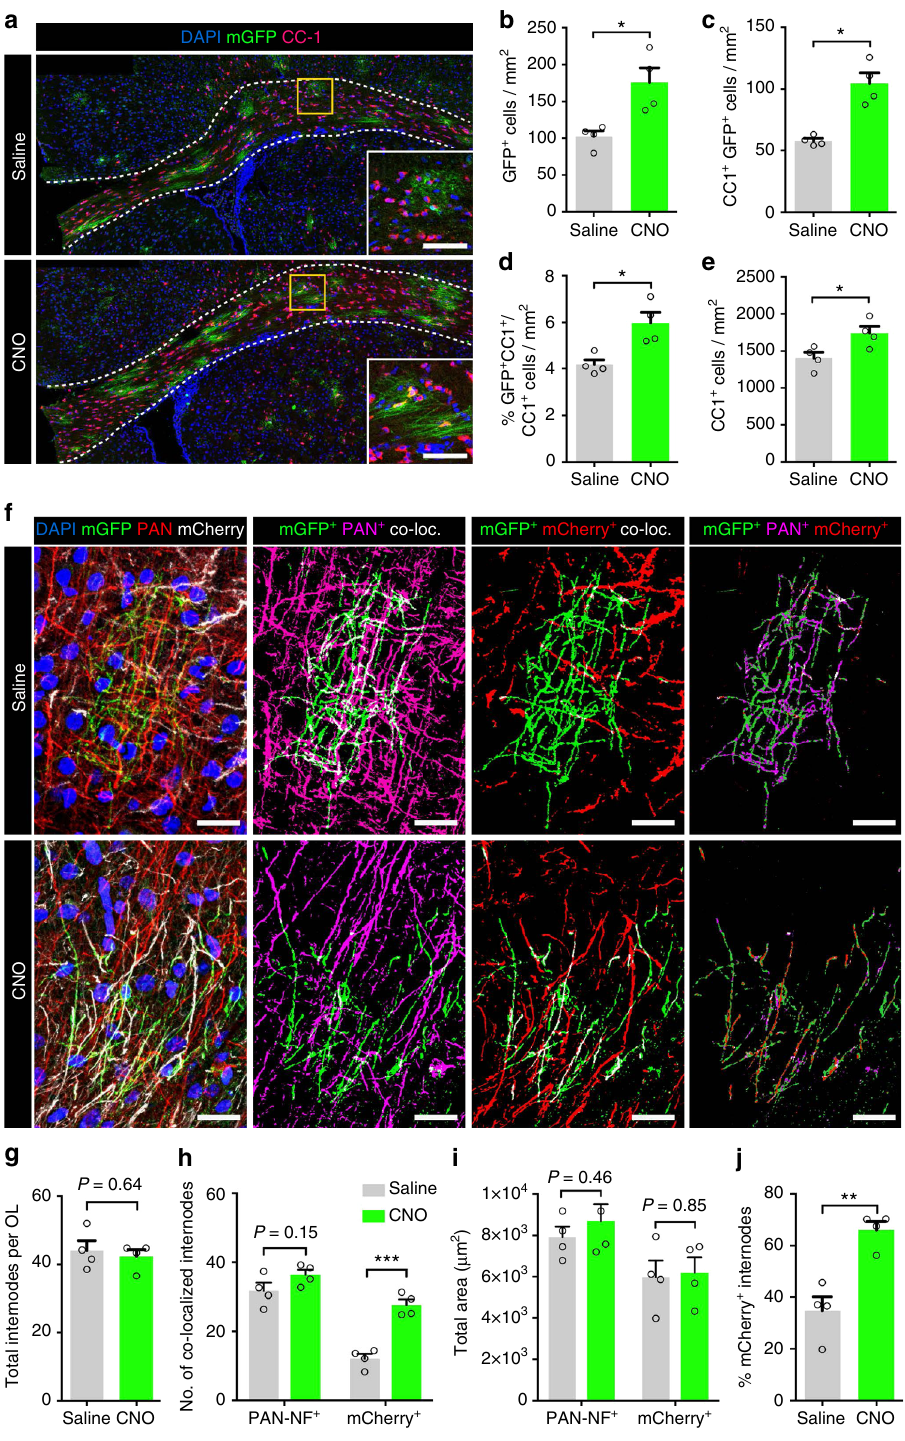
Fig. 8 Newly generated oligodendrocytes preferentially target axons with higher levels of activity. a Representative images of the corpus callosum of PdgfR α -CreERT 2 : Tau-mGFP mice that had undergone 1 week of treatment with either CNO or saline. Coronal sections were immunolabeled with mature oligodendrocyte marker CC1 (magenta) and GFP (green); insets show a higher number of doubly labeled GFP + /CC1 + cells in CNO-treated mice (bottom inset) compared to saline controls (top inset). b , c Quanti fi cation of the density of GFP + cells ( b ) and the density of CC1 + /GFP + cells ( c ) in the corpus callosum of CNO- or saline-treated mice. d , e Quanti fi cation of the percentage of all CC1 + cells that were GFP + ( d ) and the total density of CC1 + cells ( e ) in stimulated and non-stimulated mice. f Representative images of newly differentiated cortical oligodendrocytes, demonstrating colocalization with PAN-NF + or mCherry + axons. g Analysis of the total number of internodes per oligodendrocyte. h Quanti fi cation of the number of internodes that were ensheathing PAN-NF + or mCherry + axons in each condition. i The total cortical area occupied by either PAN-NF + or mCherry + processes was similar in both CNO- and saline-treated mice. j The percentage of all internodes per oligodendrocytes that ensheathed mCherry + axons was higher in CNO-treated mice compared to saline controls. Welch ’ s corrected unpaired two-tailed t -test: *** P < 0.001, ** P < 0.01, * P < 0.05; n = 4 mice/condition, ± s.e.m. Scale bars = 200 µ m ( a ), 40 µ m (insets), 20 µ m ( f